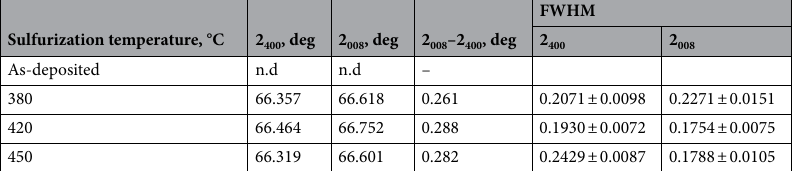
Sulfurization temperature,